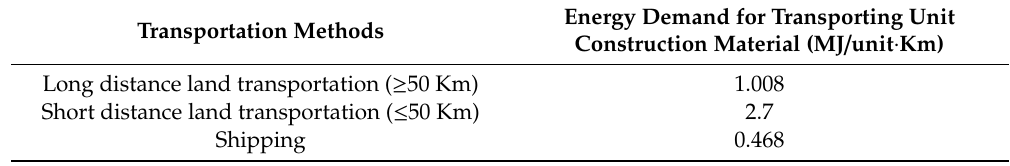
Table A4. The option value for T in Equation (7).